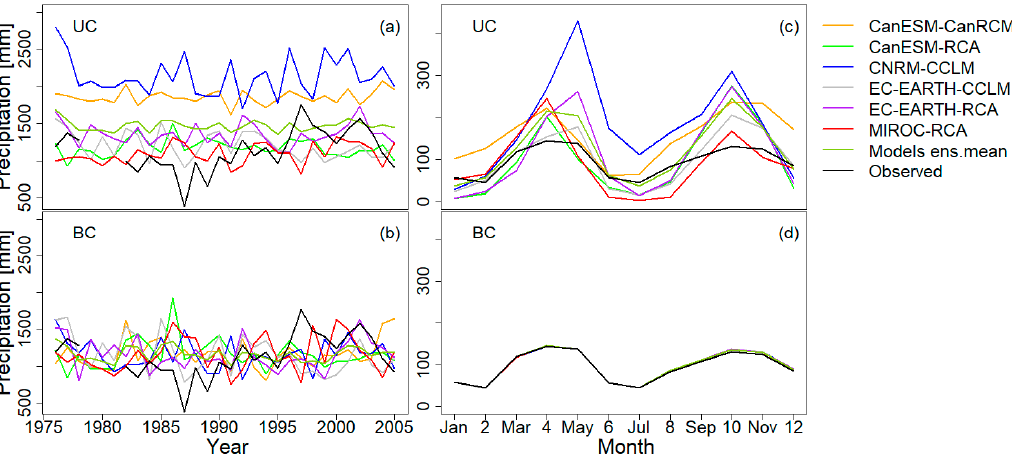
Figure 4. Historical annual ( a , b ) and mean monthly ( c , d ) precipitation (1976–2005). UC is non-bias- corrected data and BC is bias-corrected data.